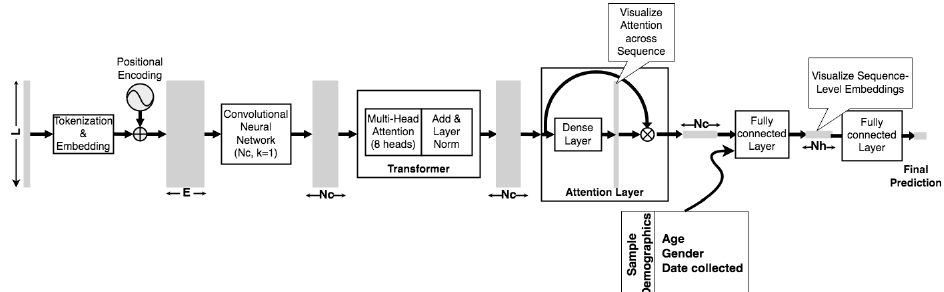
Figure 1. Deep learning architecture used in this paper. The input is a sequence of length L , tokenized as described in the Methods section. The input is embedded using trainable weights in a matrix with both token and positional information. The embedding is compressed using a CNN layer with N c filters and fed to a multi-head attention Transformer encoder. The encoder output is processed by a self-attention layer, enabling attention visualization corresponding to each amino acid site in the protein sequence. The output of the attention layer is then optionally concatenated with an additional vector of integers, here additional patient characteristics such as age. The result is input to a densely connected layer with N H nodes, where, typically, N H << L , allowing us to analyze the distances between sample vectors embedded in an optimal classification space, for example in a t-SNE plot of embedded vectors. Finally, a sigmoid activation node can provide a binary class